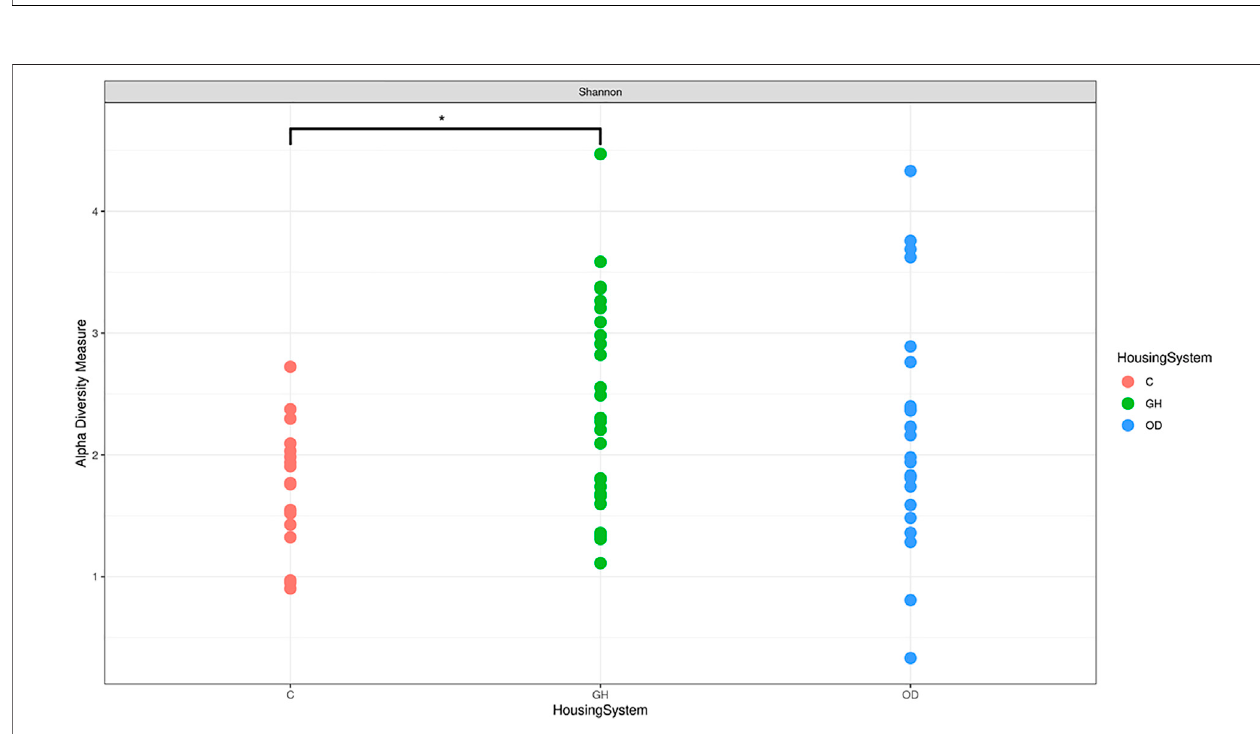
FIGURE2| DifferencesinmicrobiotaShannonalpha-diversityincrates(C)( n =9),indoorgroup-housing(GH)( n =14),andoutdoorgroup-housing(OD)( n =13).(*) Statistical signi fi cance ( q = 0.0359) in alpha diversity richness in GH group versus C group.